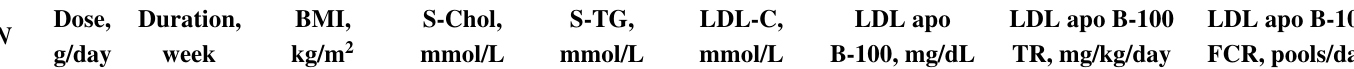
Table 1. Low density lipoprotein (LDL) kinetic